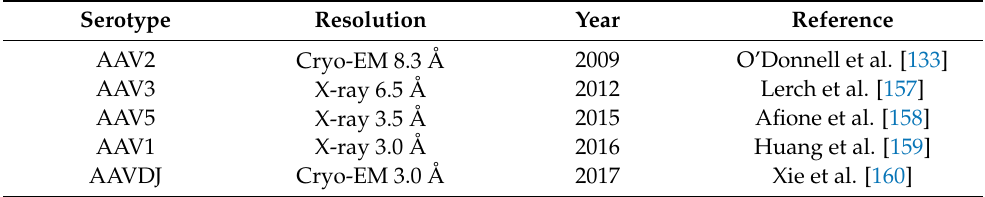
Table 2. Structures of AAV with Attachment